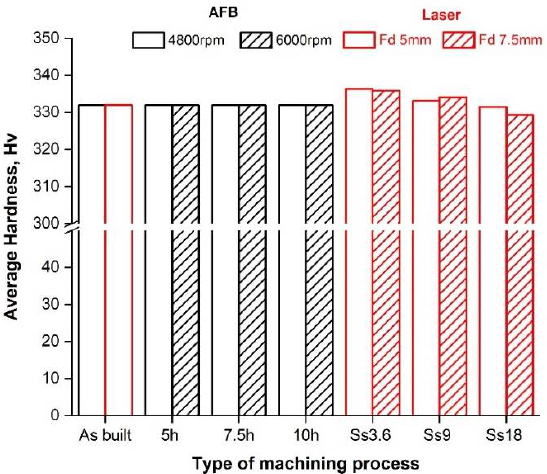
Figure 7. Dimensional variation of the treated samples at different process conditions.